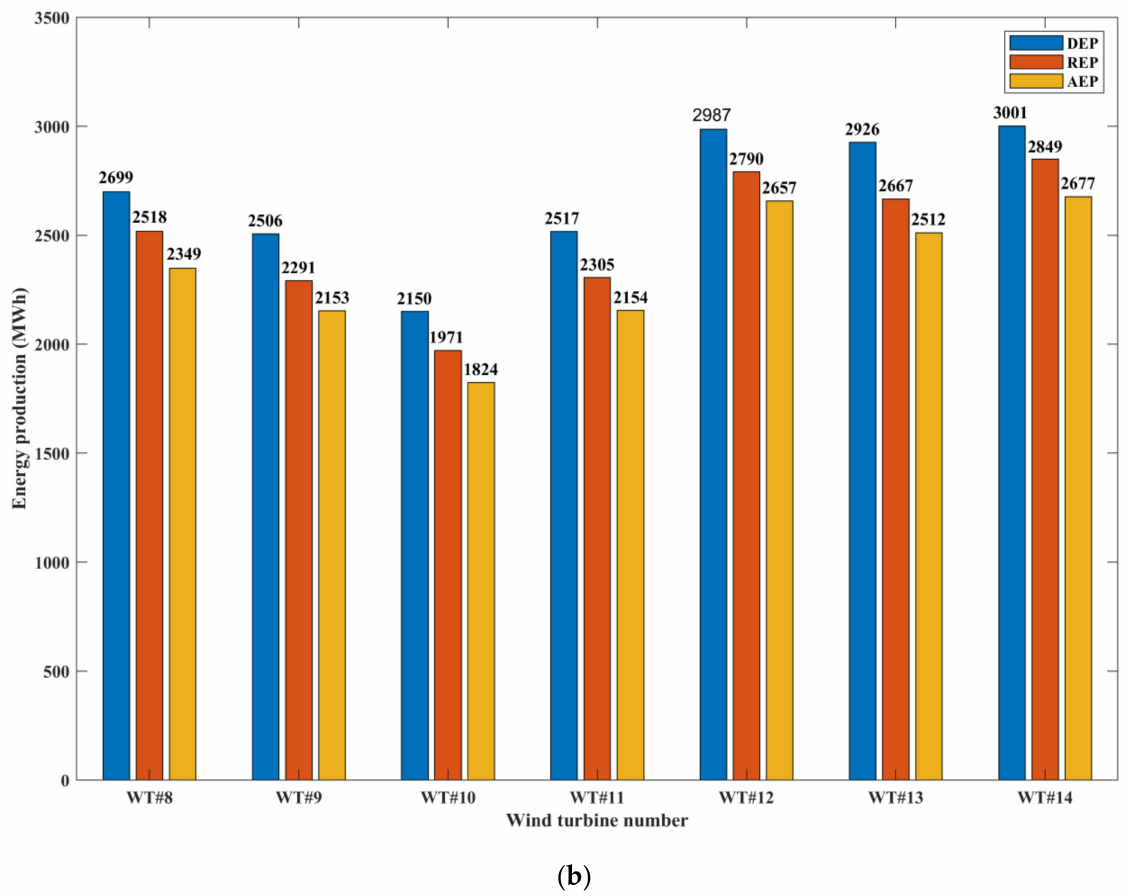
Figure 4. The calculation results of DEP/REP/AEP of wind turbines. ( a ) WT #1–7; ( b ) WT